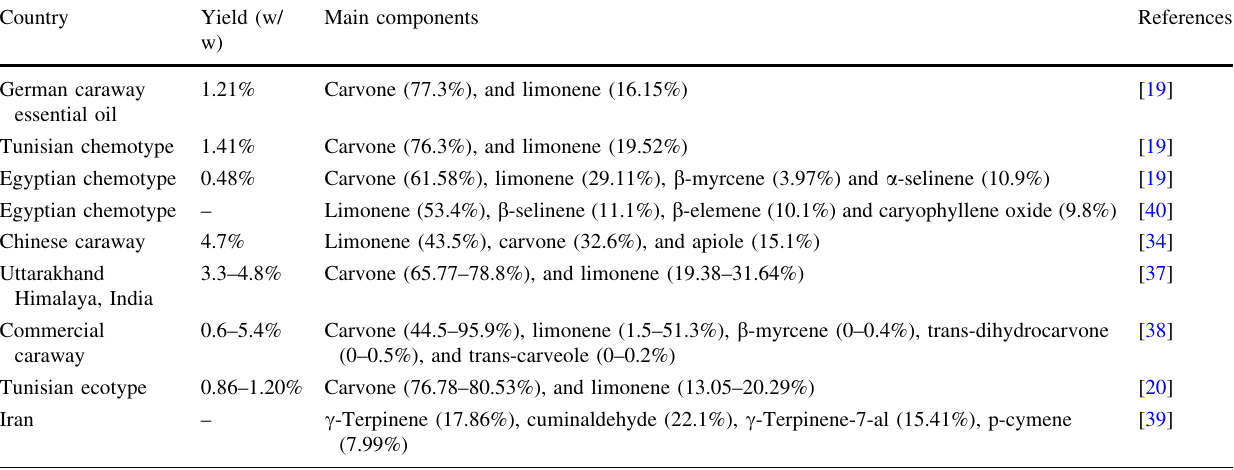
Table 1 Chemical composition of Caraway oil from different geographical region